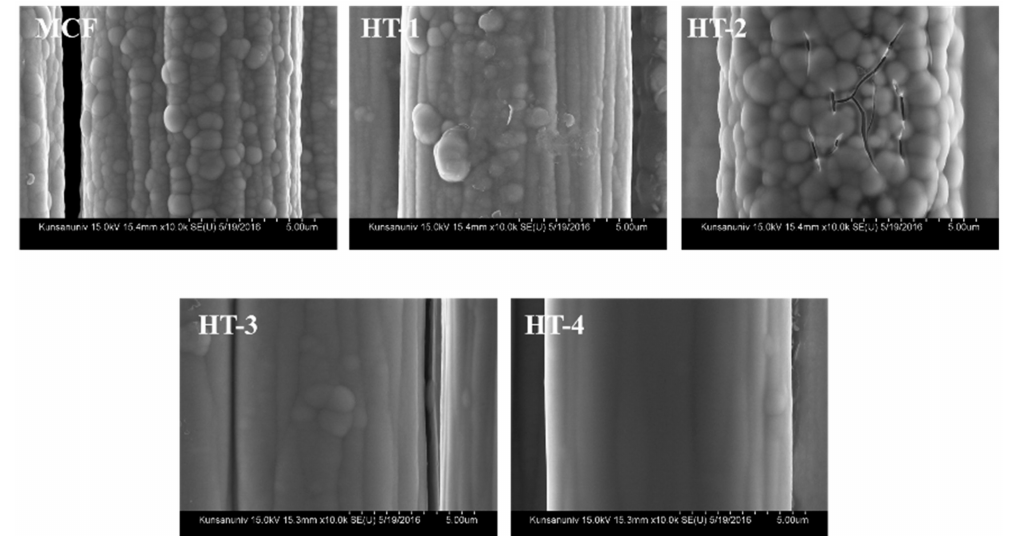
Figure 5. SEM images of MCF as a function of heat treatment time.